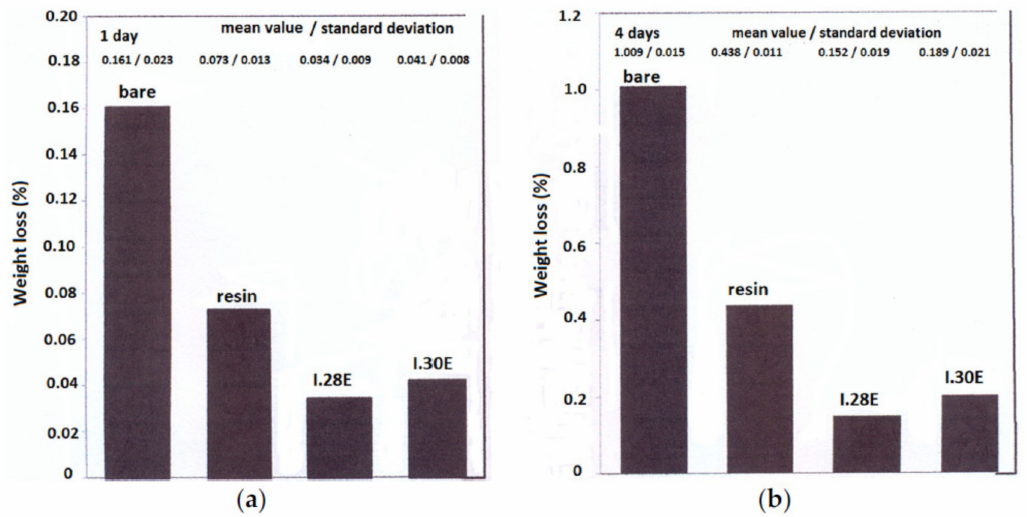
Figure 12. Weight loss results from salt spray experiments for bare steel and steel coated with pristine epoxy resin, and nanocomposites with I.28 and I.30 organo-clays, after 1 day ( a ) and 4 days ( b ) of exposure in a corrosive environment of 100% saturated moisture + 5 wt. % NaCl solution (used with copyright permission)